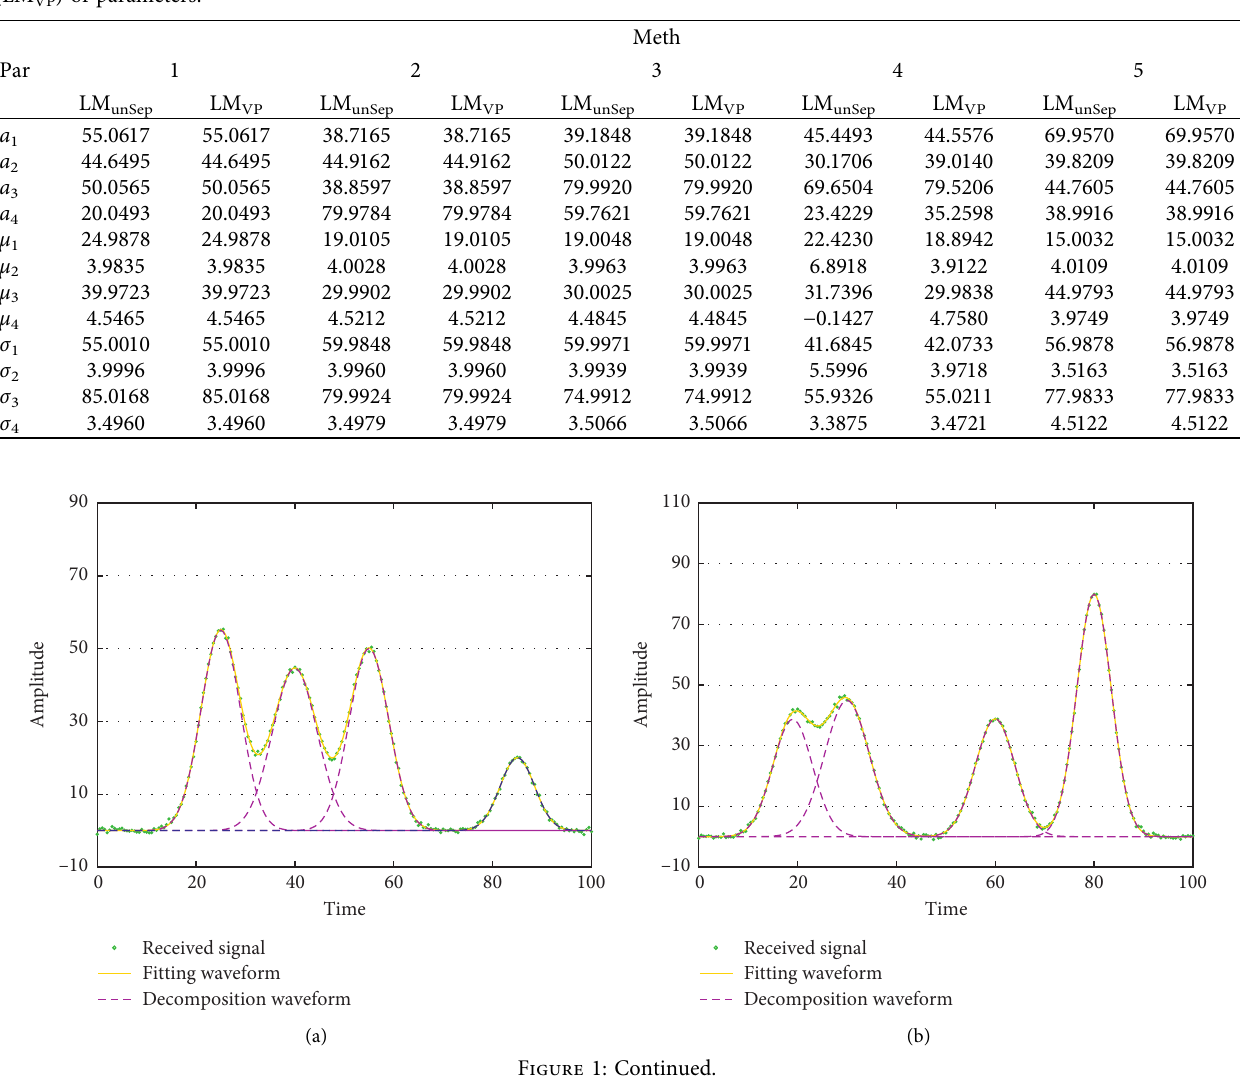
unSep ) and with separation